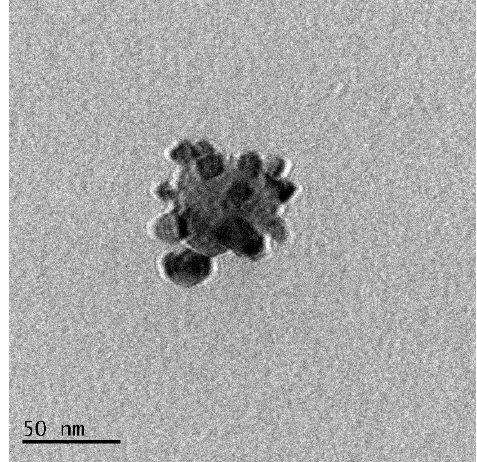
Figure 14. TEM image of the Fe 3 O 4 @Ag nanoparticles.